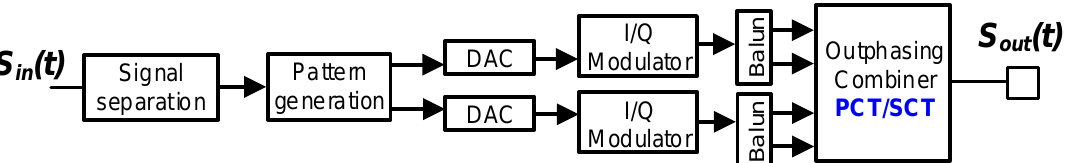
Figure 4. Block diagram for simulations of the outphasing combiner.